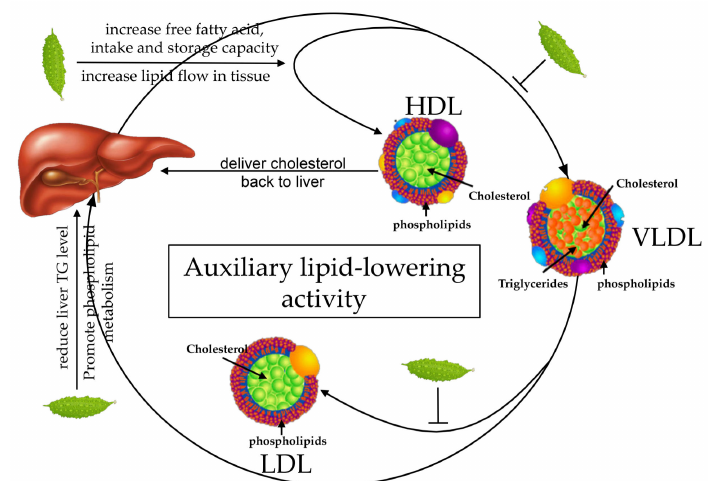
Figure 5. Possible mechanisms contributing to the auxiliary lipid-lowering activity of M. charantia . M. charantia reduce the elevated levels of serum cholesterol, phospholipids, triglyceride (TG), and low-density lipoprotein (LDL). On the contrary, M. charantia increases the high-density lipoprotein (HDL) level by elevating lipid flow in the